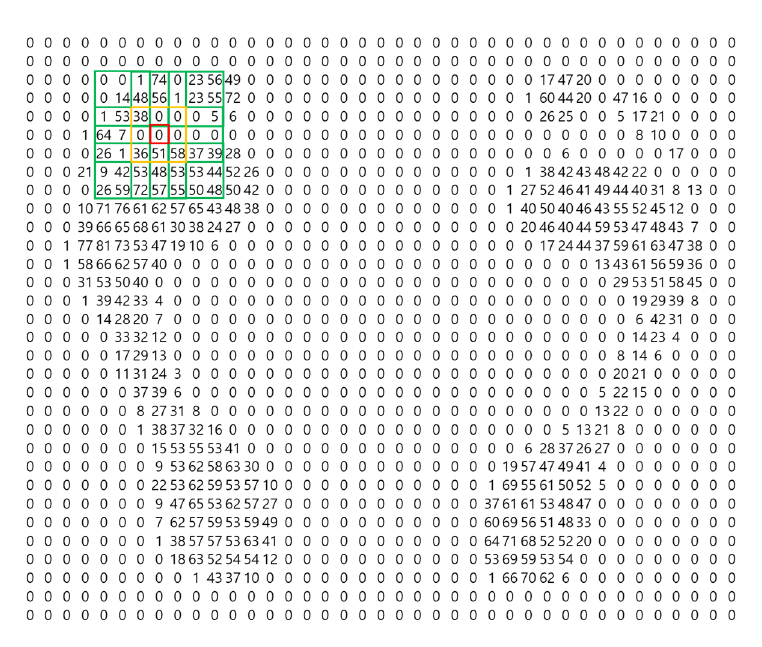
Figure 3. Candidate search for the arch between toe and sole of foot candidate search.